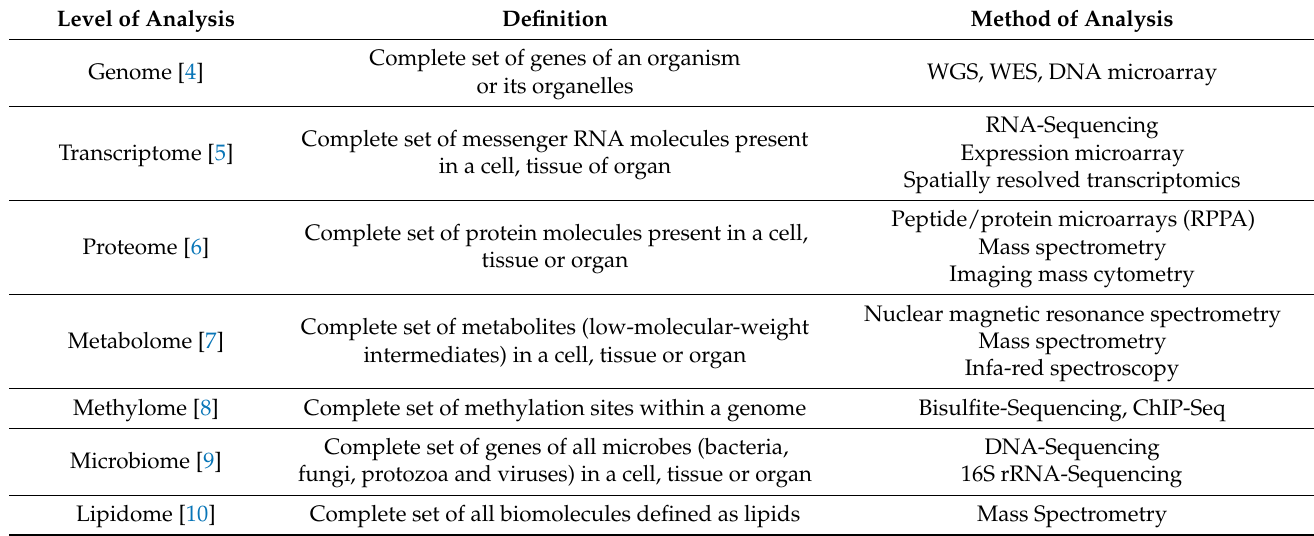
Table 1. Different omics levels of gene-function